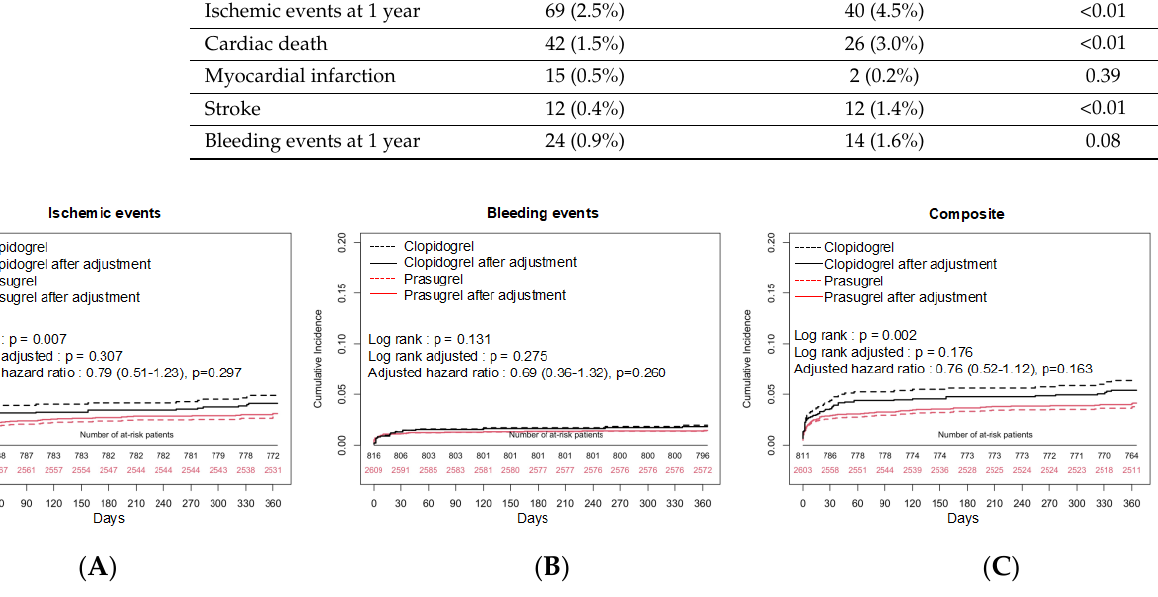
Figure 1. Kaplan–Meier survival curves showing the efficacy endpoint (ischemic events, ( A )), safety endpoint (bleeding events, ( B )), and composite endpoint (composite of ischemic and bleeding events, ( C )) before and after adjustment using the inverse propensity of treatment weights.